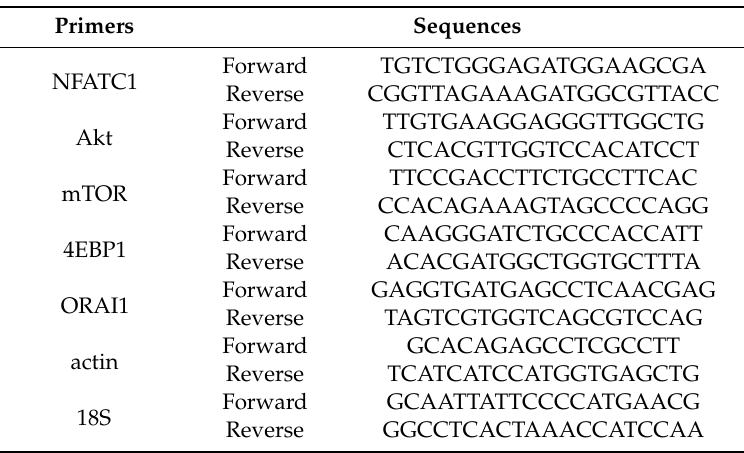
Table 1. Sequences of primers